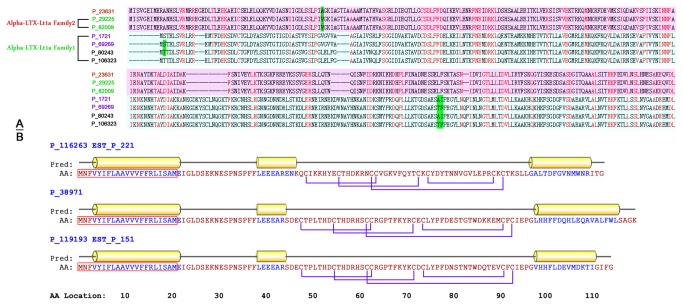
Examples of new toxins.A) Sequence alignment of seven members of the α-LTX-Ltla-1/2 families. P23631 is the Uniprot ID for α-LTX-Ltla-2, a well-known toxin of Latrodectus
tredecimguttatus. The other six proteins are new potential toxins found in our core dataset. Amino acid residue point mutations are marked in green; Residues conserved across two families are marked in red. The two families are indicated by pink and cyan backgrounds. B) The secondary structure of three new toxins (P_206187, EST_P_221, P_141871, EST_P_151 and P_208737, members of the ctenitoxin family) is shown. The amino acids forming an alpha helix are colored in blue; red rectangles indicate predicted signal peptides; purple lines represent disulfide bridges.